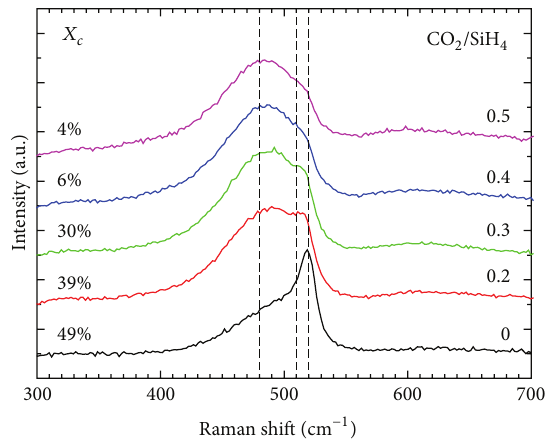
Figure 3: Raman spectra of p- 𝜇 c-SiO:H films with different CO 2 / SiH 4 ratios.